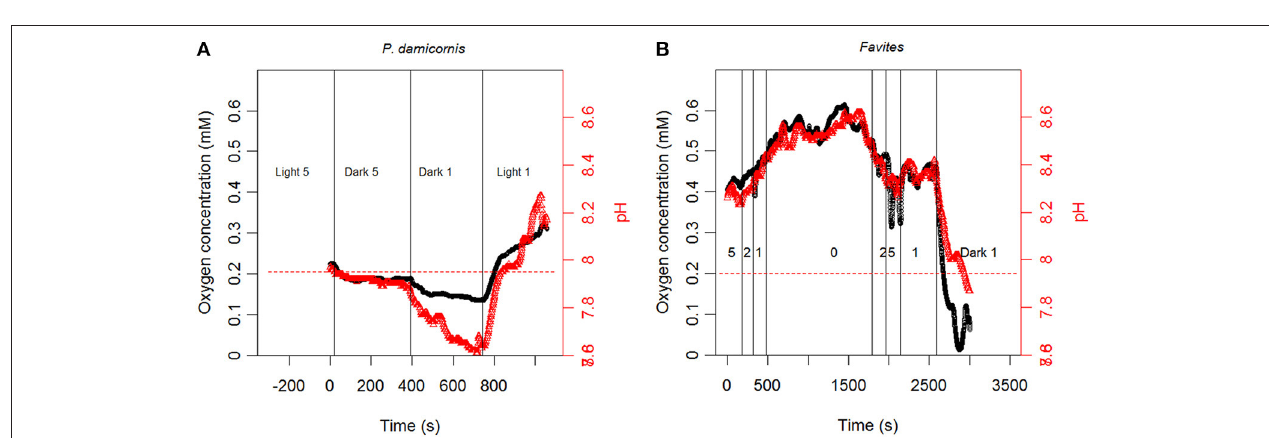
FIGURE 3 | Continuous measurement of tissue surface O 2 concentration (black line) and pH (red line) for (A) P. damicornis and (B) Favites under varying light/dark and flow conditions. Conditions in (B) are in light (800 µ mol photons m − 2 s − 1 ) unless stated otherwise. Numbers in figure represent flow velocity. Red dashed line represents pH in bulk